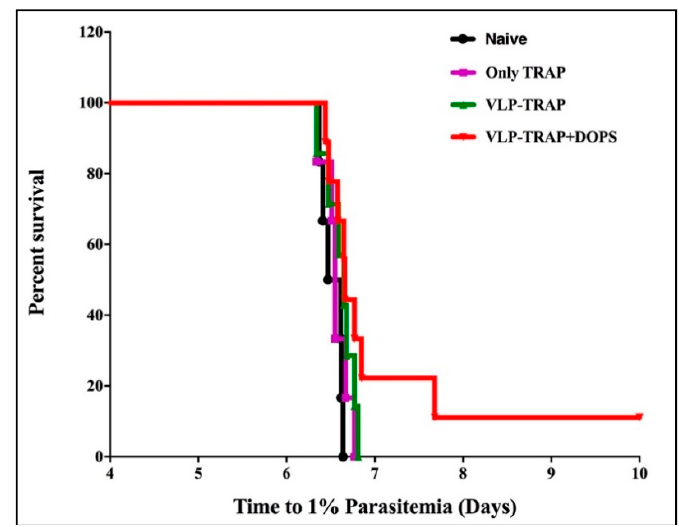
Figure 7. Kaplan–Meyer survival curve showing when the CD1 mice reached 1% or more of parasitemia or did not have any infected erythrocytes, which is considered to be sterile protection. The only group of mice showing some sterile protection was the group of mice vaccinated with PfTRAP-VLP plus DOPS (red line). Parasite load was counted daily in blood smears until 14 days after challenge and kept for another two weeks under observation to check for signals of disease. The group of mice immunized with PfTRAP-VLP plus DOPS conferred significant protection ( p = 0.0001) when compared to the group control vaccinated with TRAP only.